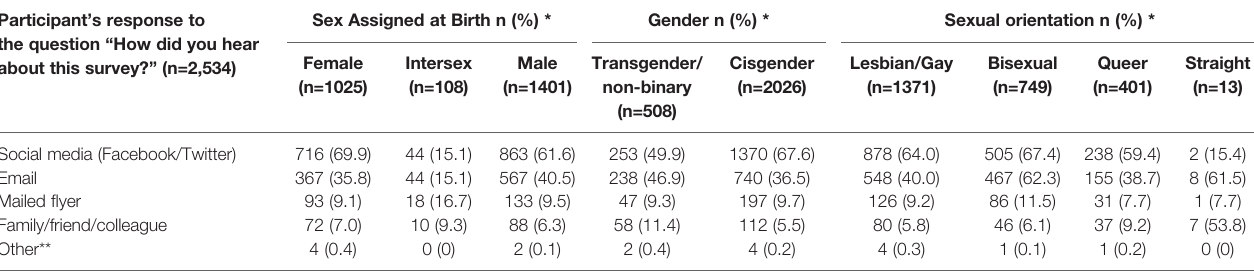
TABLE 2.2 | Survey respondents from fi nal data.